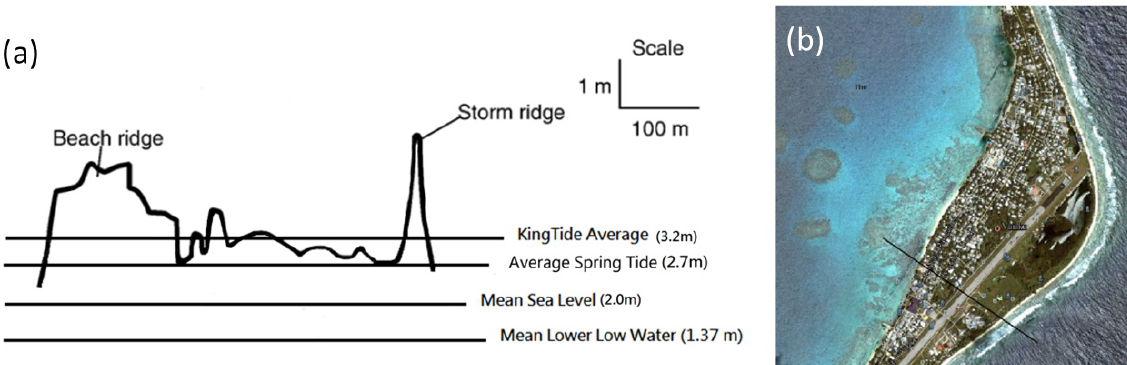
Fig. 4. A terrain profile of Fongafale, Tuvalu. Left map is drawn by the profile of black line in right image. The framework (a) was accessed from Yamano et al. (2007), while the image of Fongafale (b) was accessed from Google